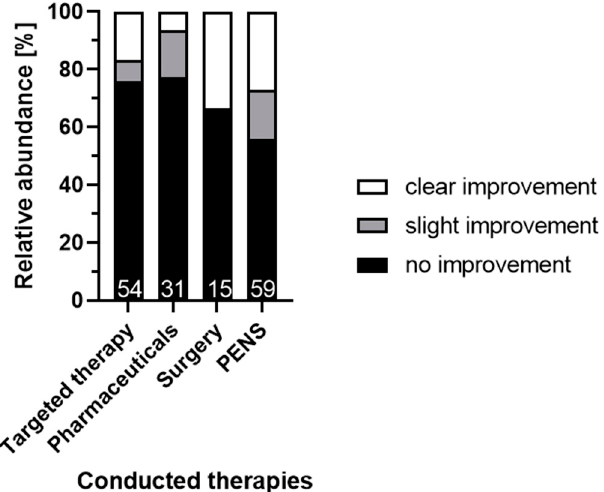
Figure 3. Comparison of responsiveness to different conducted therapies. Relative abundances for every therapy are shown [%]. Absolute abundances are shown at the bottom of every box (white numbers). There was no significant difference concerning the outcome between the conducted therapies (Pearson’s chi-squared test, Table S5). Targeted therapy was conducted in case of certain suspicious findings. Pharmaceuticals included either gabapentin, carbamazepine, cyproheptadine, or corticosteroids in recommended dosages [10]. Conducted surgeries were implantation of coils in the infraorbital canals or glycerol injections within the trigeminal ganglia. PENS: percutaneous electrical nerve stimulation (technique according to EquiPENS TM